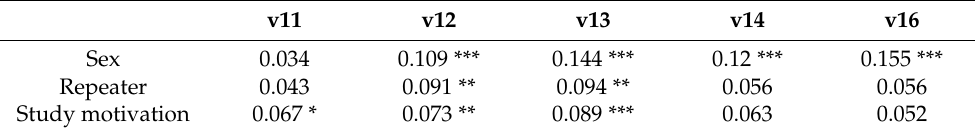
Table 6. Cramer’s V test. Perception of the degree of difficulty in assimilating the competences. v11 v12 v13 v14 Sex 0.034